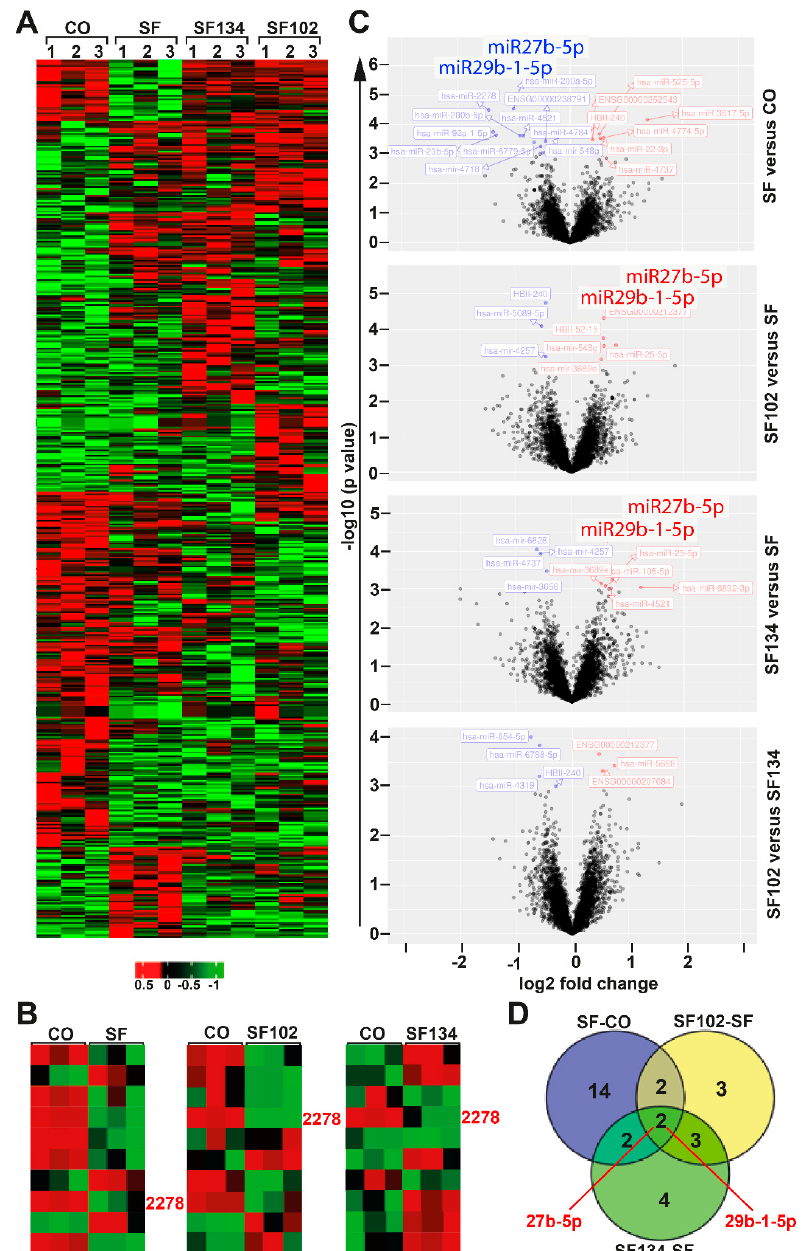
Figure 6. miRNA expression profiling reveals differential expression induced by sulforaphane, SF102 or SF134. ( A ) AsPC-1 cells were treated with 10 µM sulforaphane (SF), SF102 , or SF134, or were left untreated (CO). After 24 h, RNA was isolated and analyzed by a GeneChip miRNA 4.0 Array in triplicates. The heatmap presents the top significantly regulated miRNAs. The red color marks high expression, and the green color marks low expression within a scale from 0.5 to –1, as indicated. ( B ) The 3 heatmaps present the top 10 significantly regulated miRNAs. miR2278 is highlighted in pink color. ( C ) Volcano plots show the miRNA distribution. On the y-axis, the –log10 p value is plotted, and on the x-axis, the fold change is plotted. ( D ) A Venn diagram shows the distribution of differentially expressed miRNAs among three groups: SF—CO, SF102 —SF, and SF134 —SF. The overlapping region identified two miRNAs, miR27b-5p and miR29b-1-5p, which are differentially expressed between sulforaphane, SF102 and SF134.